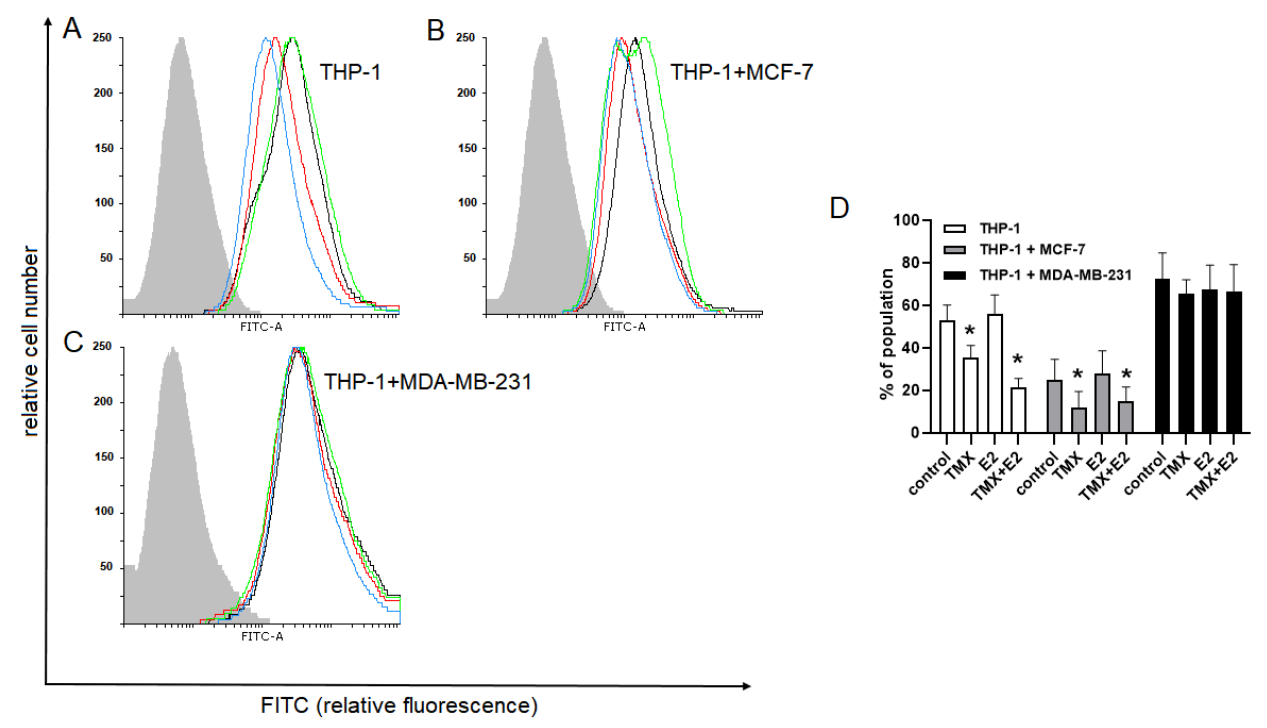
Figure 2. Expression of Arg-1 in monocytic THP-1 cells grown in a monoculture ( A ) or the presence of MCF-7 ( B ) and MDA-MB-231 ( C ) cells in a co-culture transwell system and exposed to TMX and/or E2. Representative histograms ( A , B , C ) and corresponding bar graphs ( D ) were derived from flow cytometric analyses of 10,000 cells and show the isotype of the control (light grey histogram), the control cells (black line), TMX-treated cells (red line), E2-treated cells (green line) and cells concomitantly treated with TMX/E2 (blue line). Data are presented as the median percentage of each population (mean of 5 separate determinations). * p < 0.05 vs. the corresponding control group.